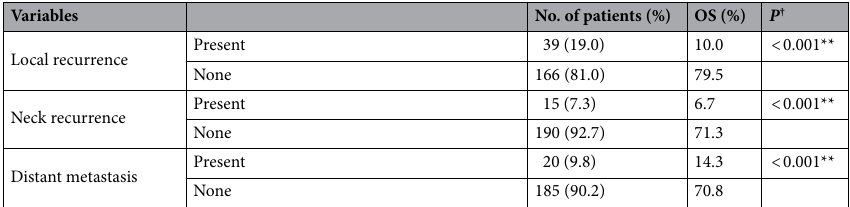
Table 2. Characteristics of OSCC patients in relation to cumulative survival. † By log-rank test. * P < 0.05 Statistically significant difference, ** P < 0.01 Statistically significant difference. OS, overall survival; NLR, neutrophil/lymphocyte ratio; SIRI, systemic inflammation response index; LMR, lymphocyte/monocyte ratio; SII, systemic immune-inflammation index; CAR, C-reactive protein albumin/albumin ratio.